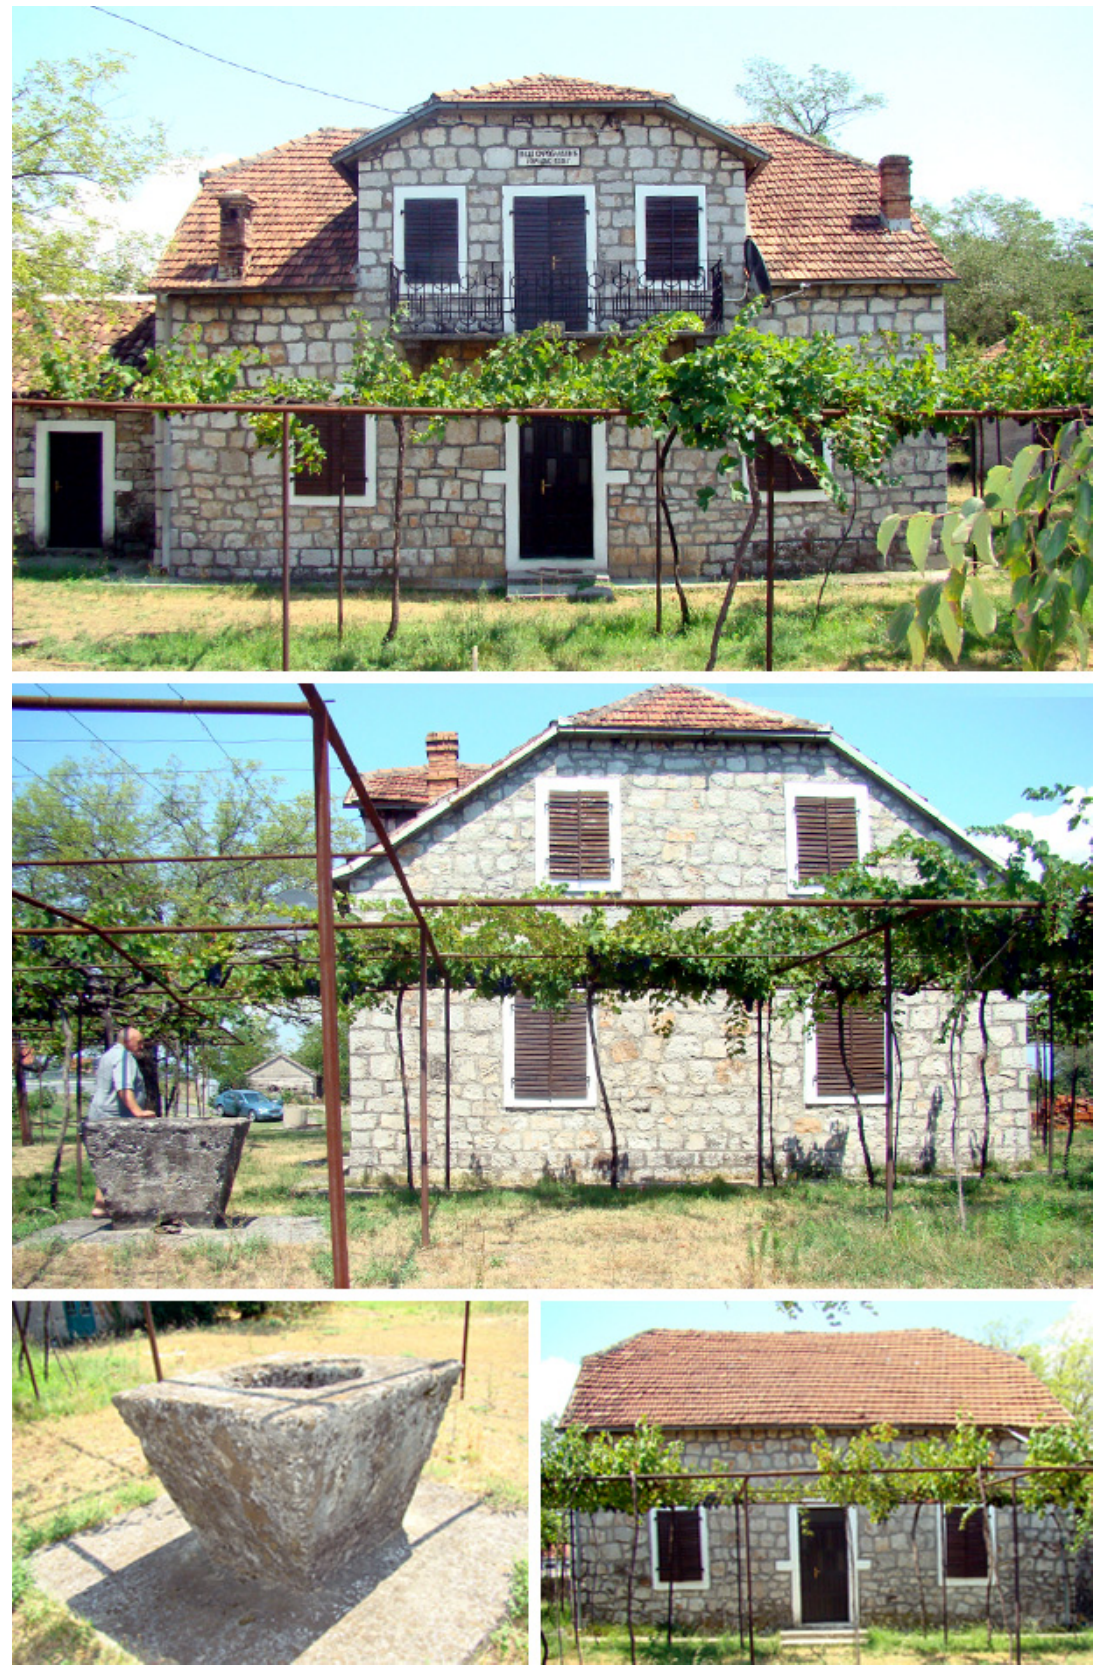
Figure 14. Photos of the House of Skrobanovic, Zeta region, Montenegro (G. Skataric).